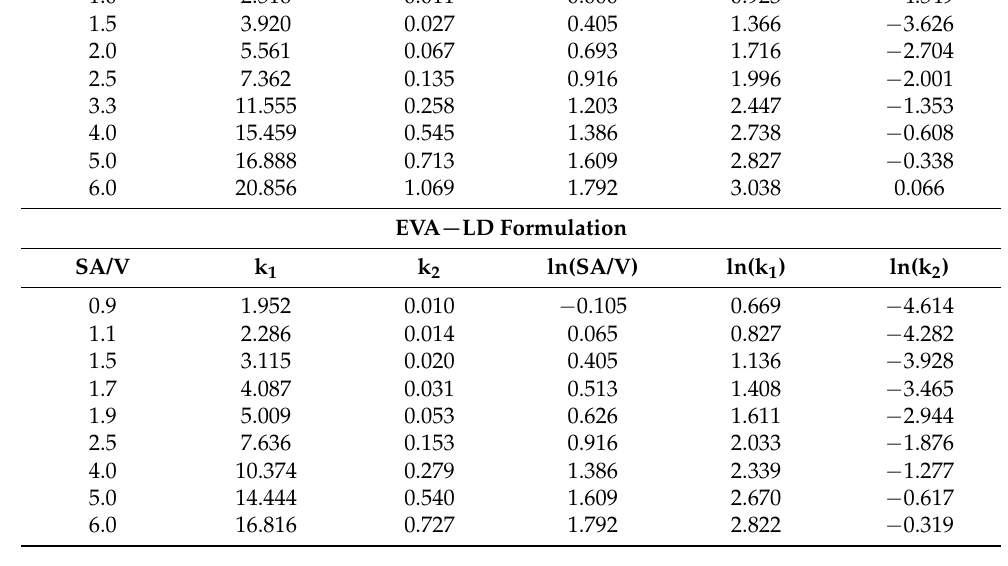
Table 8. Calculated constants for the SA/V ratios of both BCS I formulations.